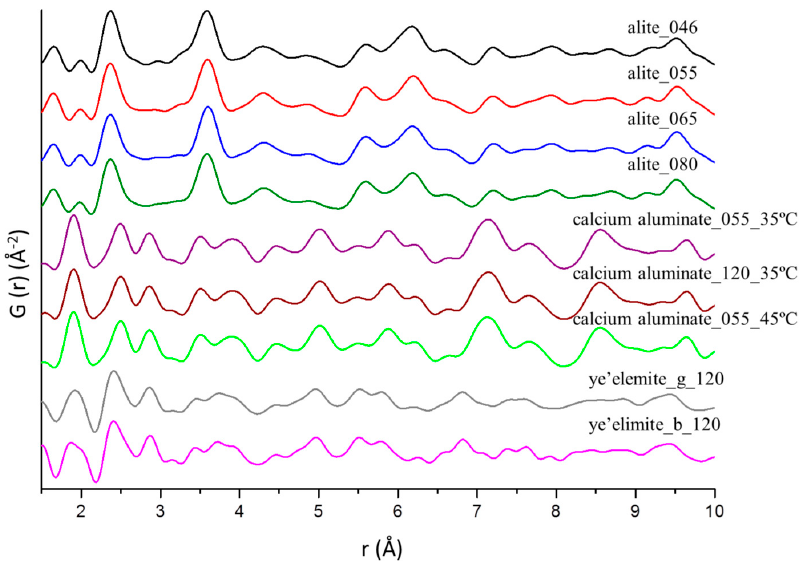
Figure 2. Experimental pair distribution function (PDF) patterns from 1.5 to 10 Å for alite, calcium aluminate, and ye’elimite pastes.